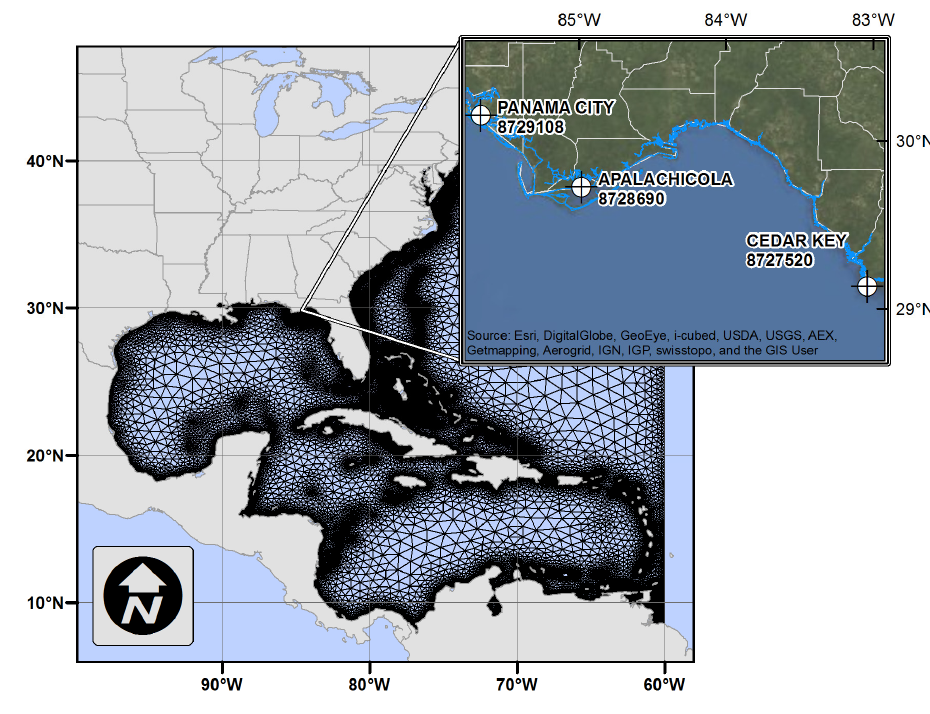
Figure 1. Tidal model domain and three tide gage station locations